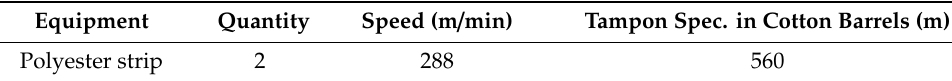
Table 4. Polyester processing parameters.